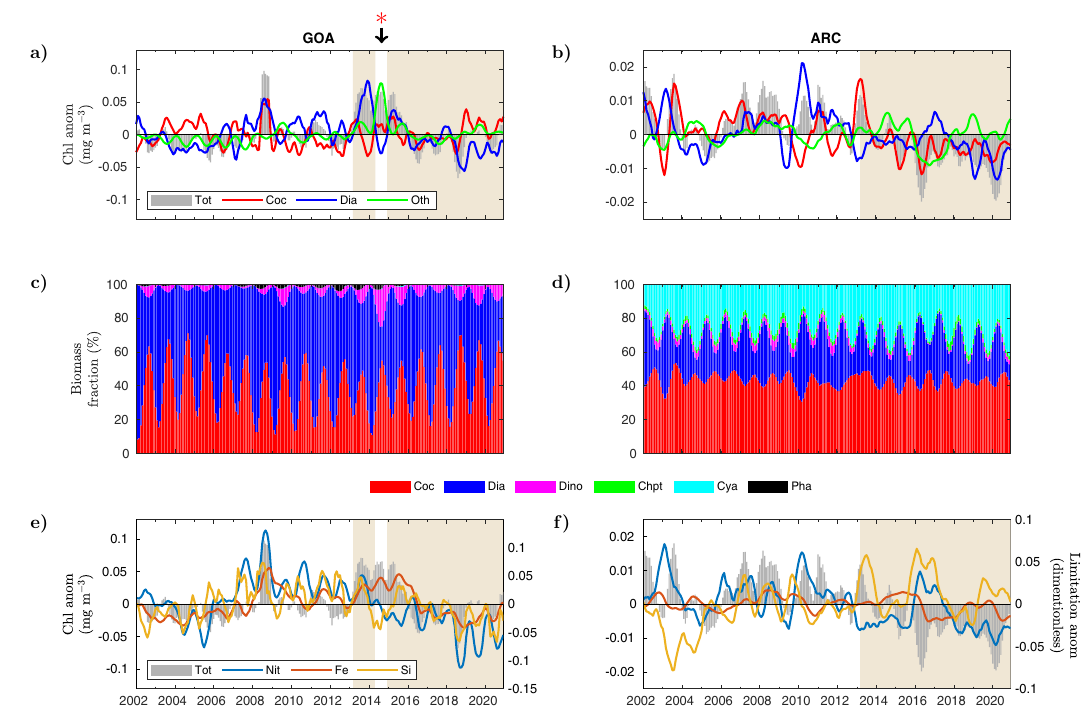
Fig. 2 Monthly anomalies in phytoplankton functional types (PFTs) and nutrient limitation in GOA and ARC. a , b ( a ) GOA and ( b ) ARC modeled anomalies (mg m − 3 ) in total surface chlorophyll (gray bars), coccolithophores (red line), diatoms (blue line), and dino fl agellates, cyanobacteria, chlorophytes, and phaeocystis combined together (summed) (green line). c , d Fraction of modeled total Chl biomass (%) corresponding to each PFT in ( c ) GOA and ( d ) ARC (coccolithophores-red, diatoms-blue, dino fl agellates-magenta, chlorophytes-green, cyanobacteria-cyan, and phaeocystis-black). e , f Anomalies in modeled surface chlorophyll (mg m − 3 ) (gray bars) and the growth-limiting term (unitless) of nitrate (blue), iron (red), and silicate (yellow) in ( e ) GOA and ( f ) ARC. Area of beige background indicates the anomalously warm period starting in March 2013. Red asterisk indicates the period between May and December of 2014 when noticeable changes in modeled PFT composition occurred in GOA. Monthly anomalies are smoothed using a 6-month rolling